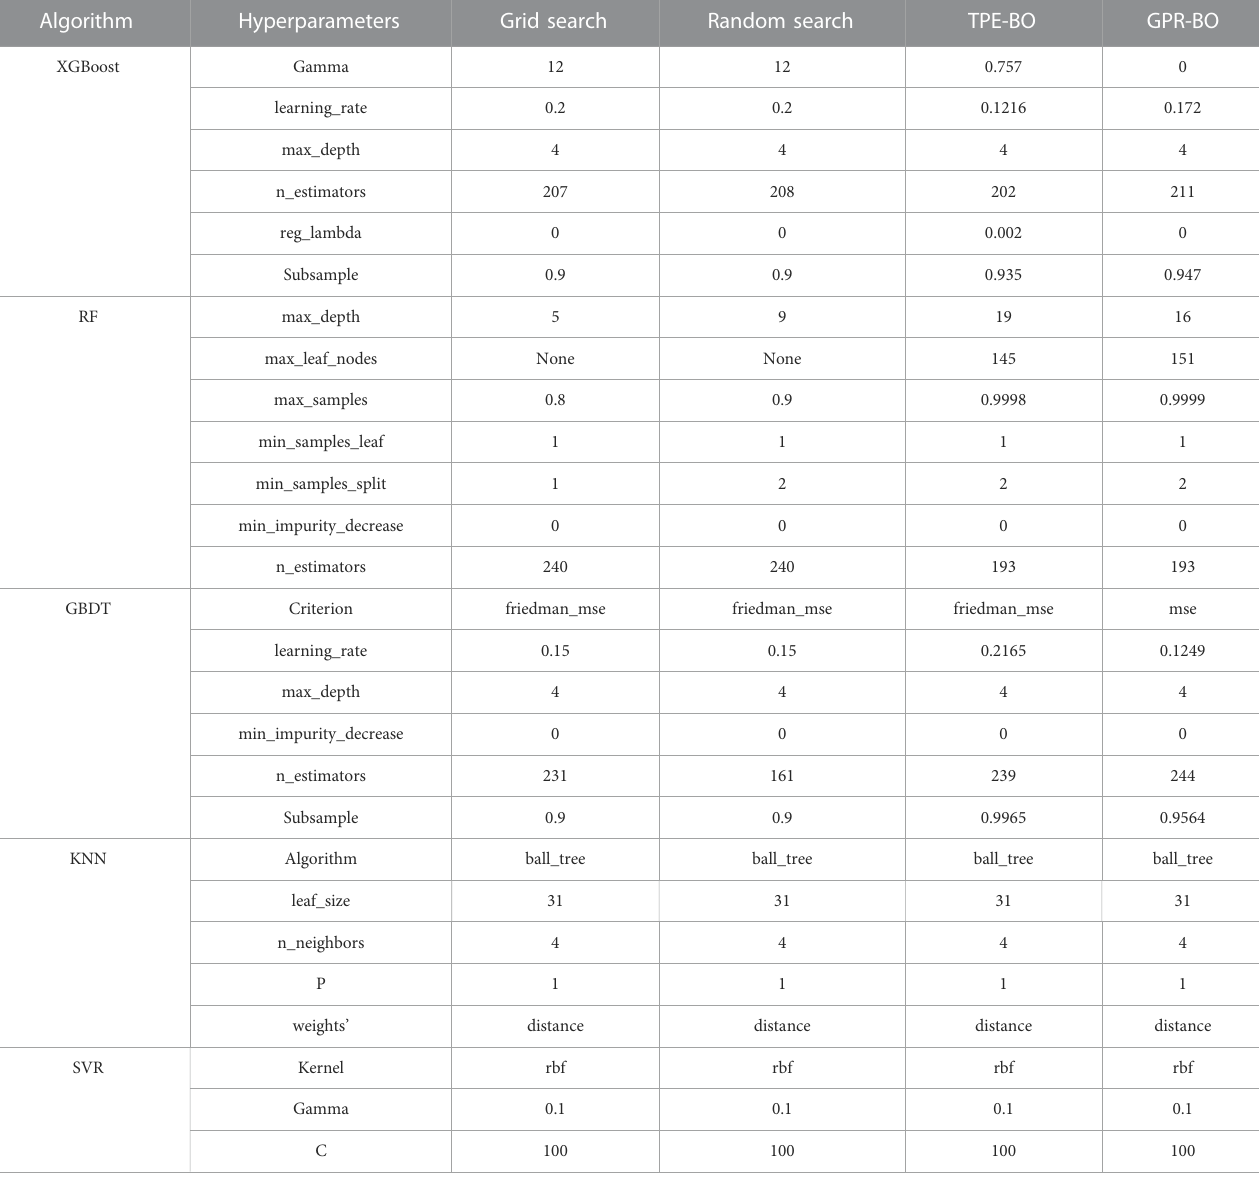
TABLE 2 The optimal combination of super parameters of prediction models determined under different hyperparameter con fi guration methods.